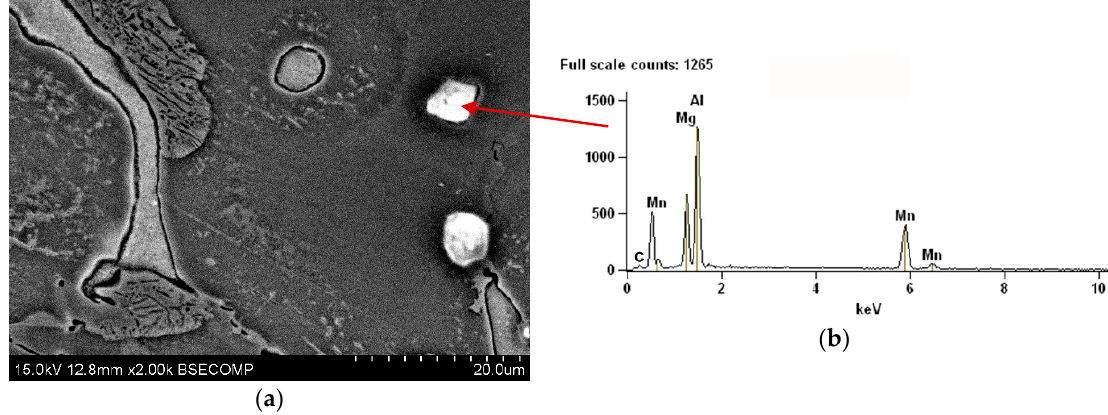
Figure 6. Carbon in Al 8 Mn 5 precipitates: ( a ) SEM, ( b ) EDS.